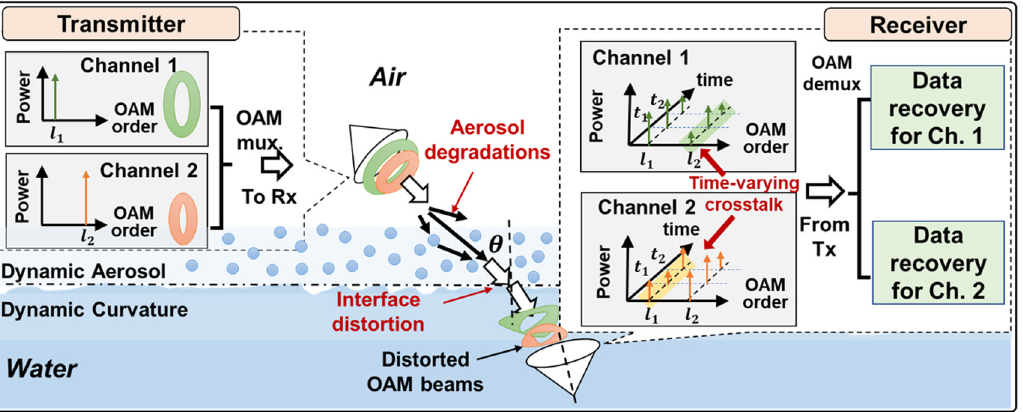
Figure 1: Concept of the OAM multiplexed link through the dynamic air – water interface. The dynamic aerosol and water surface curvature would inducetime-varying powerloss of the transmitted modeand crosstalk to neighboring modes. θ , angleof incidence;Tx,transmitter; Rx, receiver; Ch,